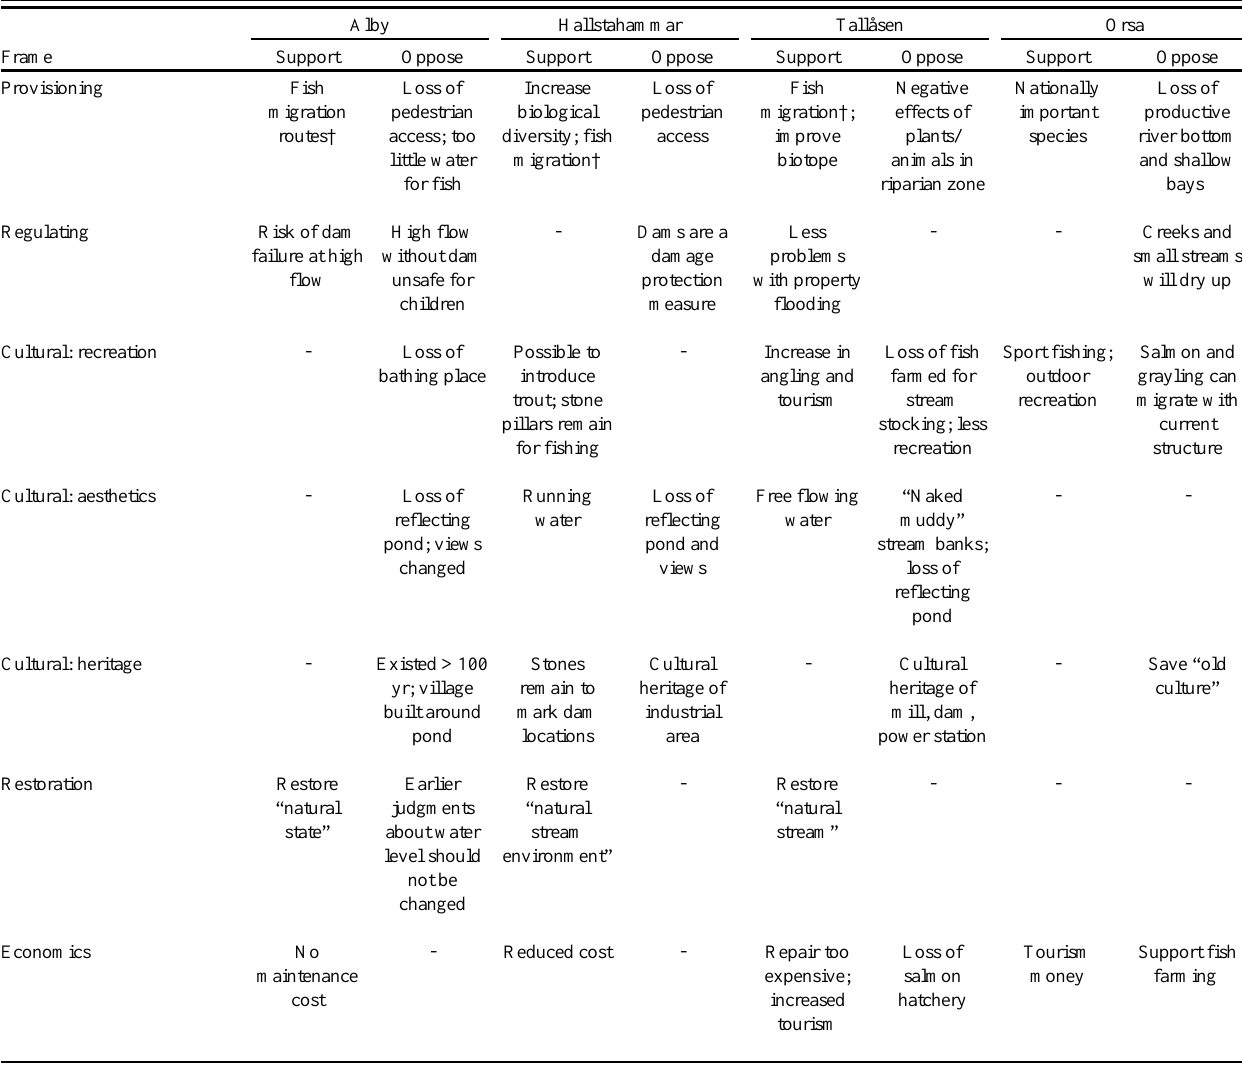
Table 1. Summary of the arguments used to support and oppose the removal of four dams in Sweden in media coverage of the conflict, categorized by the frame type